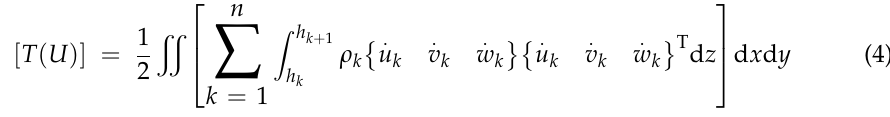
The kinetic energy [ T ( U )] is written in Equation (4), where ρ k stands for mass density of a k th layer and h k , h k + 1 represents thickness parameters of a laminated plate referring to the bottom and top surfaces for the k th layer [25].